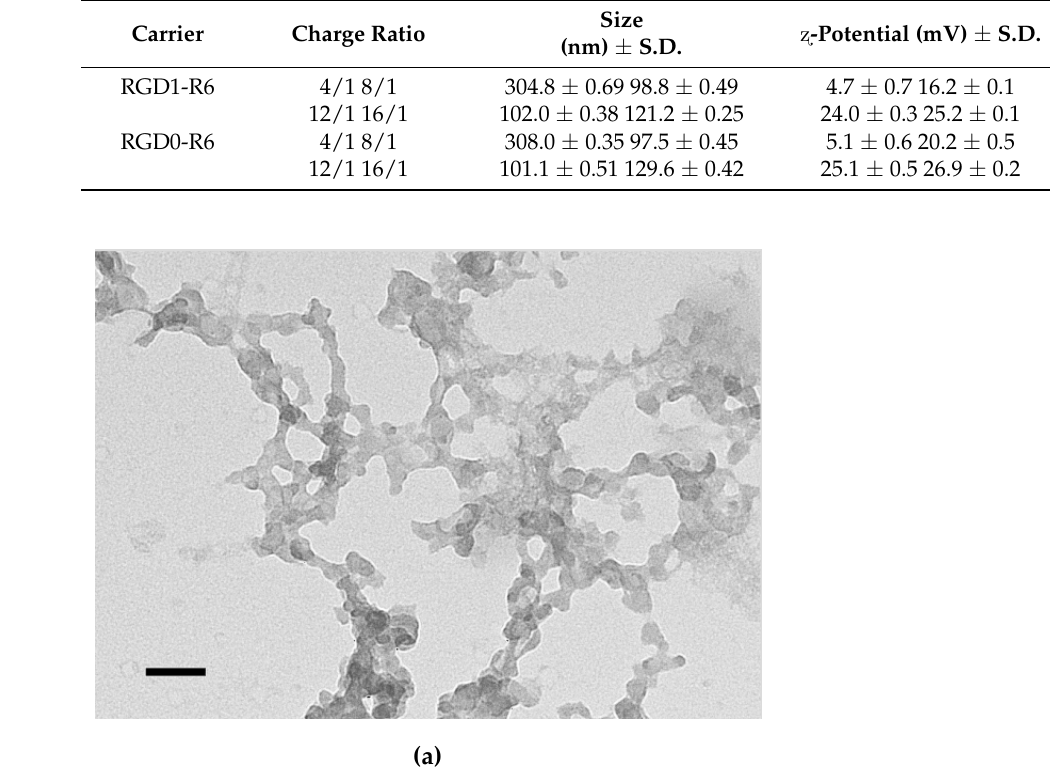
Table 2. Size and zeta-potential of the carrier/DNA complexes.